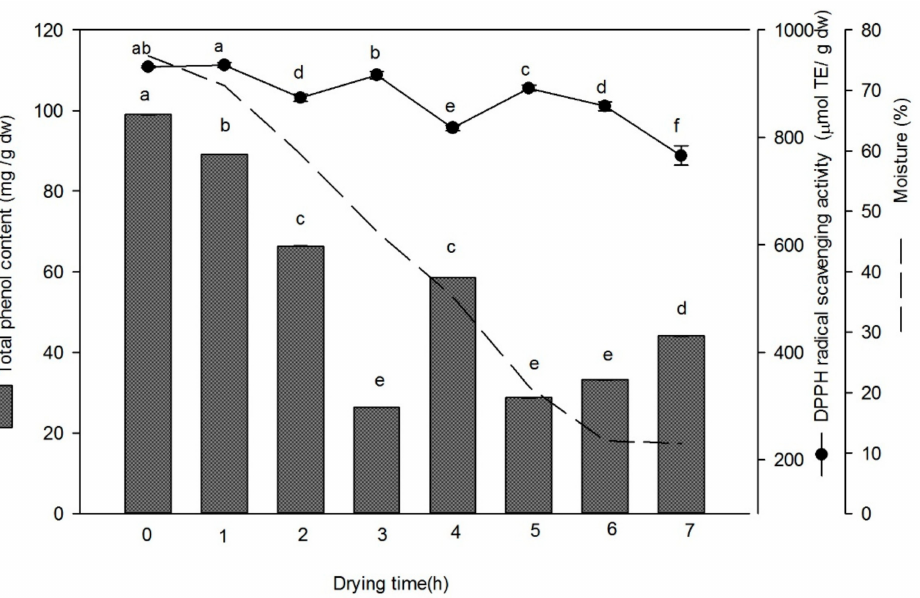
Figure 1. Effect of drying time at 40 ◦ C on total phenol content (TPC) and 2-diphenyl-1-picrylhydrazyl (DPPH) antiradical activity of stevia leaves. Similar letters indicated no significant differences ( p > 0.05) among drying